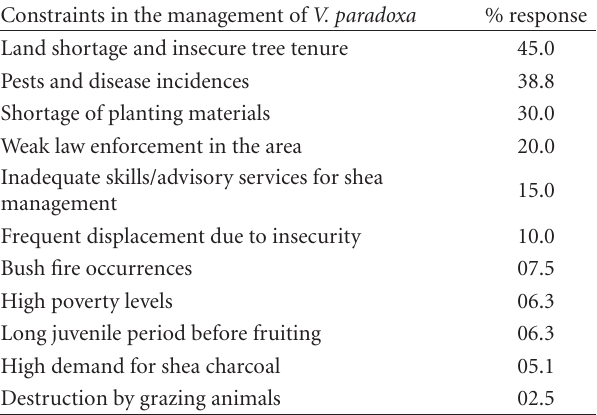
Table 3: Constraints to on-farm management of shea trees ( N =